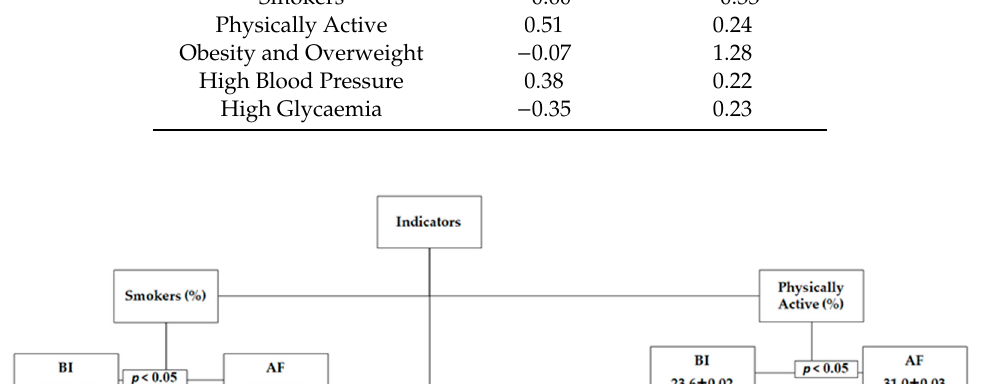
Table 4. Percent variation comparison between the test group and the Brazilian workers (2006–2015).